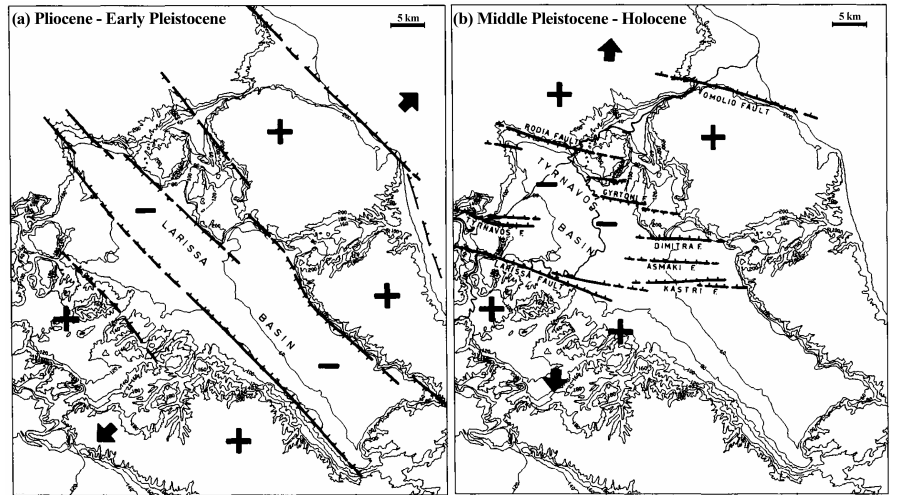
Figure 6. The latest two extensional phases, ( a ) during Pliocene-Early Pleistocene and ( b ) Middle Pleistocene-Holocene, corresponding respectively to P2 and P3 phase in Figure 7, which tectonically formed the local relief of north Thessaly. Positive and negative signs indicate uplift and subsidence respectively. Modified from Caputo et al.